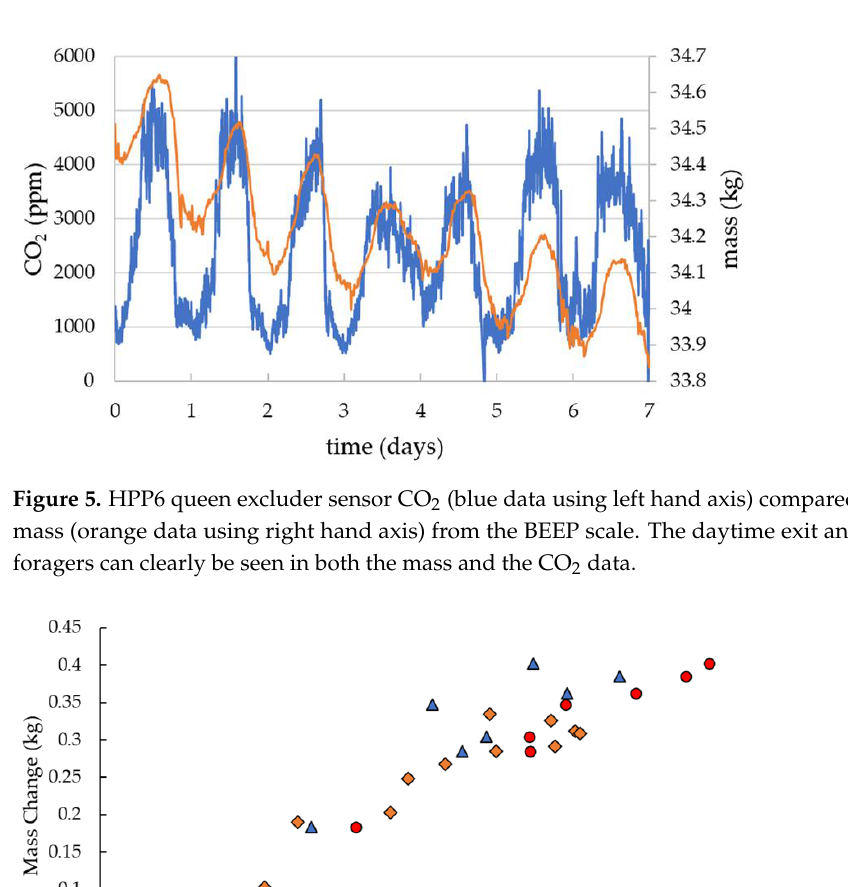
Figure 5. HPP6 queen excluder sensor CO 2 (blue data using left hand axis) compared with the hive mass (orange data using right hand axis) from the BEEP scale. The daytime exit and return of the foragers can clearly be seen in both the mass and the CO 2 data.